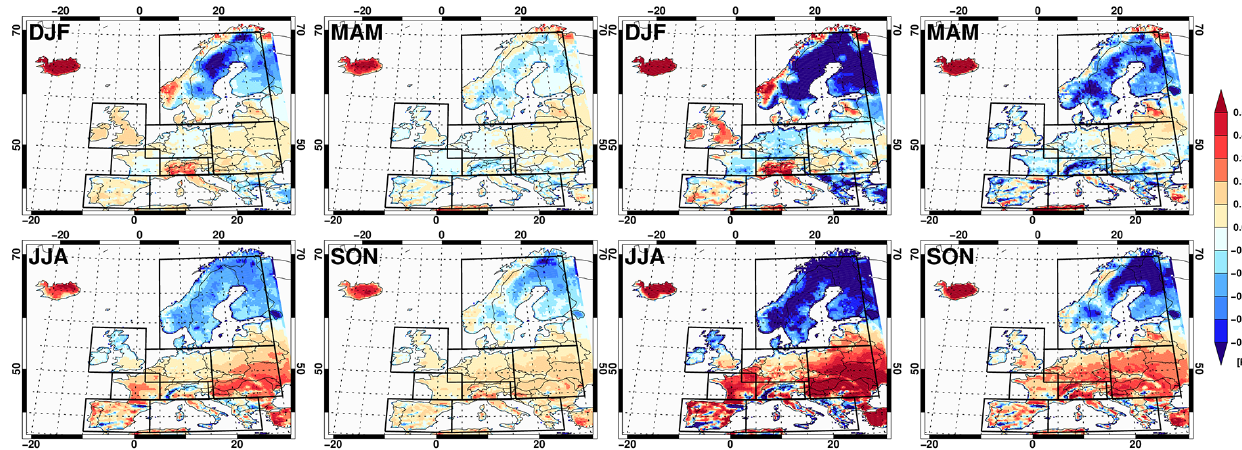
Figure 2. Differences between uncorrected and corrected (QM) multi-model mean temperature CCS. The reference period is 1971–2000. The left panels refer to CCSs in the mid-21st century (2021–2050), the right panels to the end of the 21st century (2070–2099). Blue colors indicate areas where the uncorrected model is colder than the corrected model; red colors vice versa.